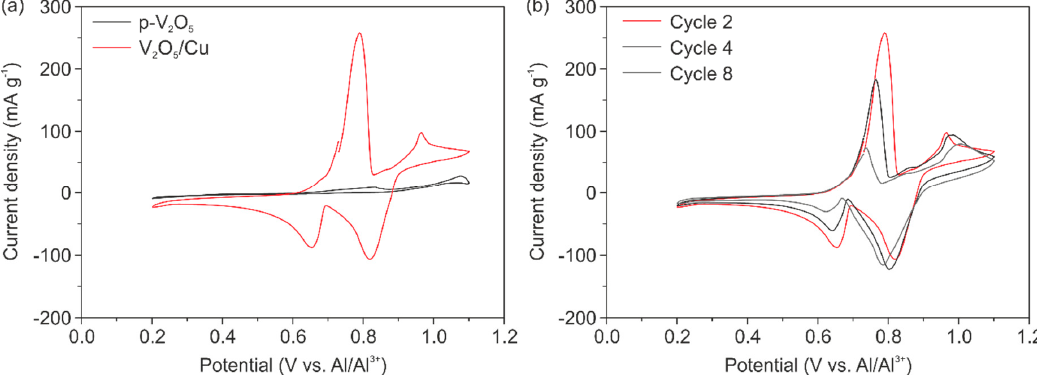
Figure 5. Cyclic voltammetry curves at a scan rate of 0.1 mV s − 1 of ( a ) second cycles for p ‐ V 2 O 5 and V 2 O 5 /Cu revealing the importance of the migrated Cu, as well as for ( b ) cycles 2, 4 and 8 of V 2 O 5